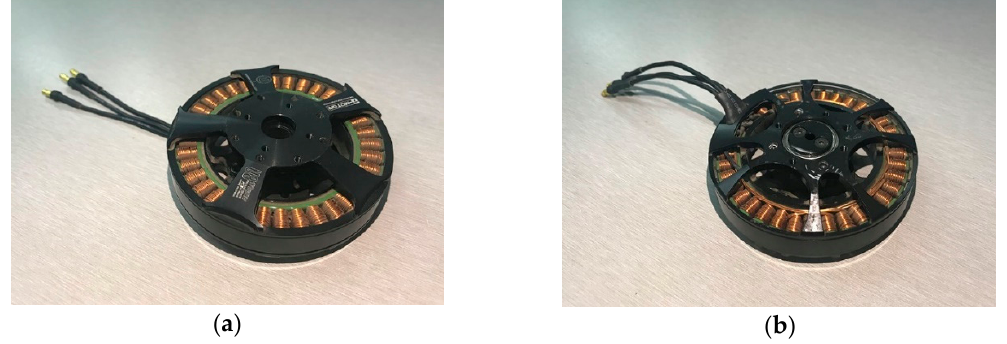
Figure 6. Photos of the U7 KV170 motor used in experiment: ( a ) Front; ( b ) Back. Table 1. Design parameters of the T-MOTOR U7 KV170 motor.